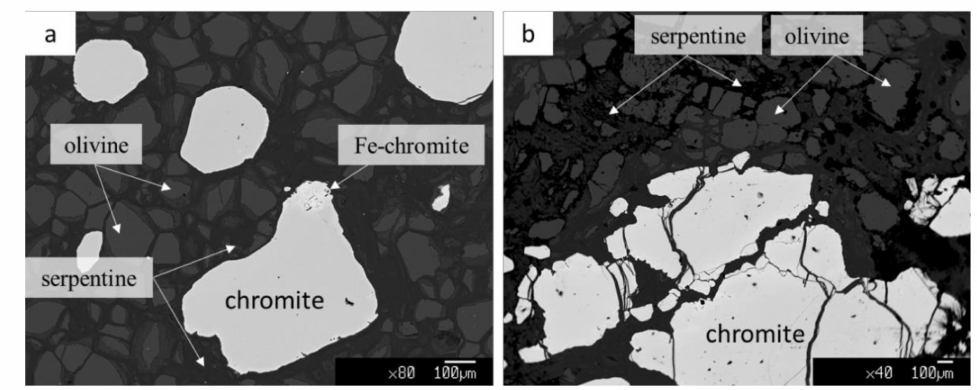
Figure 7. BSE images of Nea Roda chromitites showing alteration to ferrian chromite and serpen- tinization; details of: ( a ) banded chromitite; ( b ) nodular